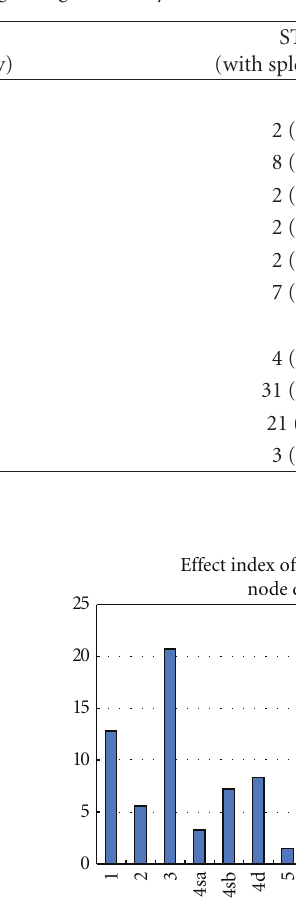
Table 2: Perioperative morbidity following total gastrectomy with or without splenectomy.